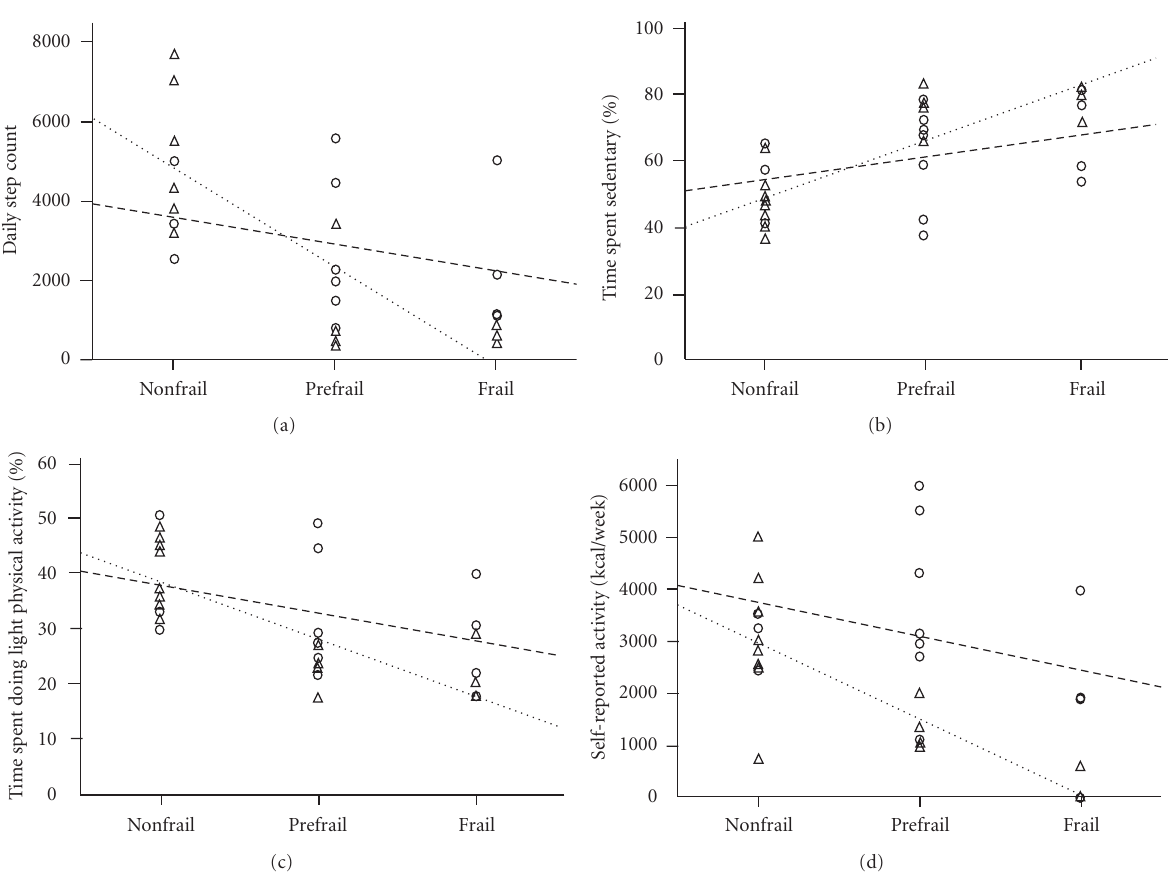
Figure 2: Relationship between frailty severity and: (a) daily step count. Total daily step count was negatively correlated with frailty severity ( r = − 0 . 79) in females without PD; (b) accumulated daily sedentary time. Sedentary time was positively correlated with frailty severity ( r = 0 . 84) in females without PD; (c) accumulated light physical activity time. Light activity time was negatively correlated with frailty severity ( r = − 0 . 82) in females without PD; (d) self-reported leisure activity. Self-reported activity was negatively correlated with greater frailty severity ( r = − 0 . 82) in females without PD. Females with PD are represented by the open circle and dashed regression line ; females without PD are represented by the open triangle and dotted regression line